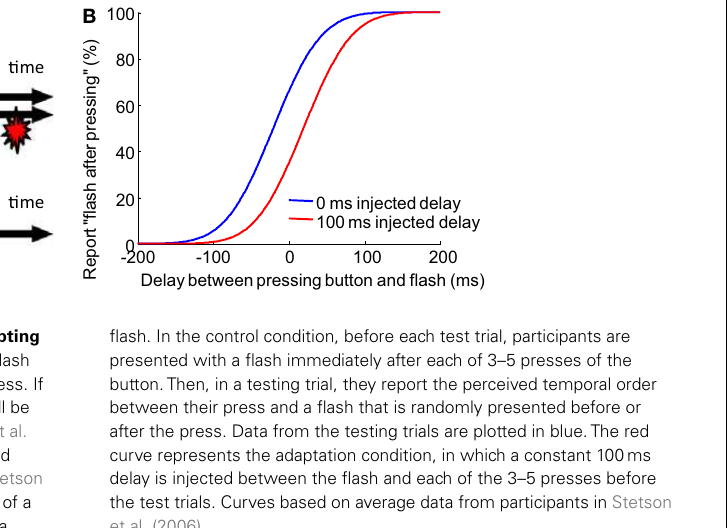
FIGURE 1 | Recalibration of temporal order judgment after adapting to a constant delay between motion and sensory event. (A) A flash consistently appears with a fixed delay ( filled icon ) after a button press. If a flash is suddenly presented with a shorter delay ( open icon ), it will be perceived as appearing before the press after calibration. Stetson et al. (2006) proposed that this is due to the relative shift of the motor and sensory time lines (i.e., temporal expectations; reproduced from Stetson et al., 2006, with permission; B) . A cartoon of psychometric curves of a participant judging the temporal order between a button press and a